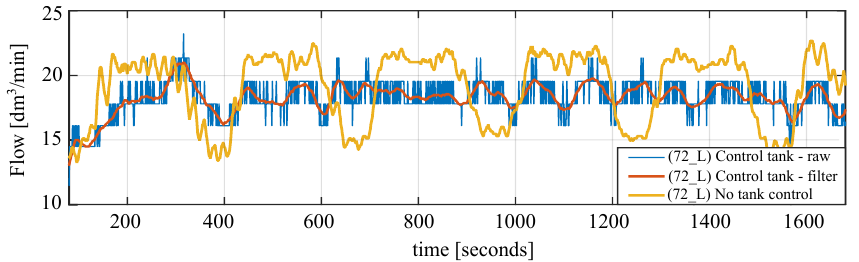
Figure 19. Graph from the experimental results of Fredericia’s study case [43]. The graph shows a comparison of the inlet flow at the treatment plant (sensor 72_L) between non-controlled industry discharge and a controlled one with